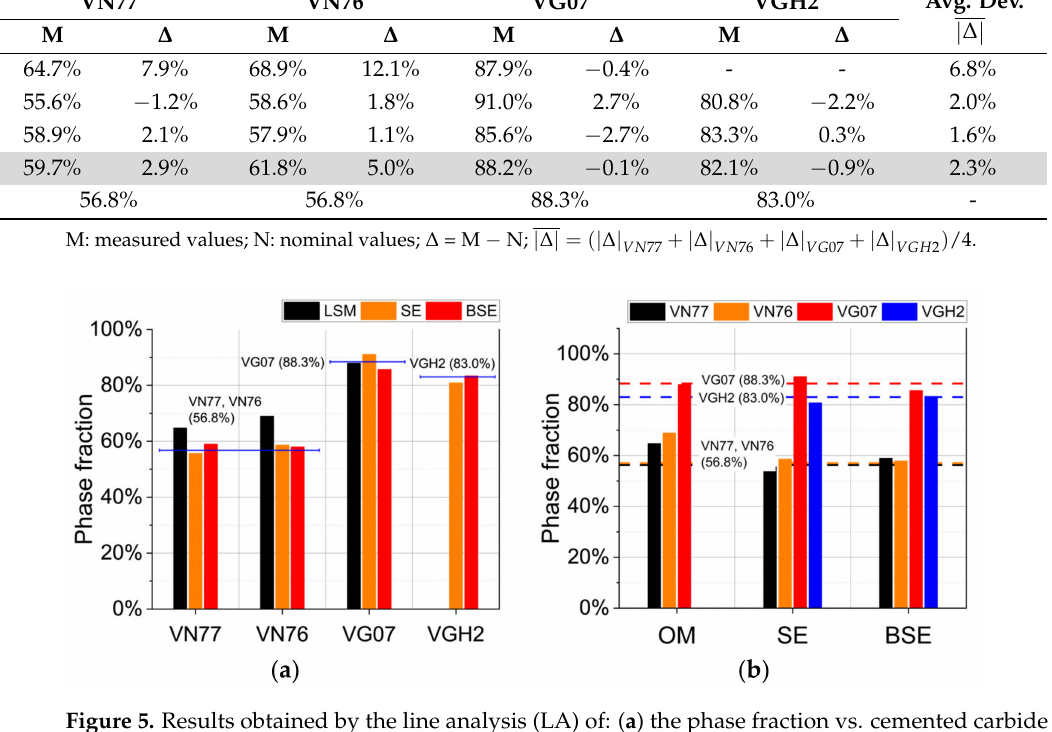
Figure 5. Results obtained by the line analysis (LA) of: ( a ) the phase fraction vs. cemented carbide grades, and ( b ) the phase fraction vs. image acquisition. Table 9. WC grain size by the LA.